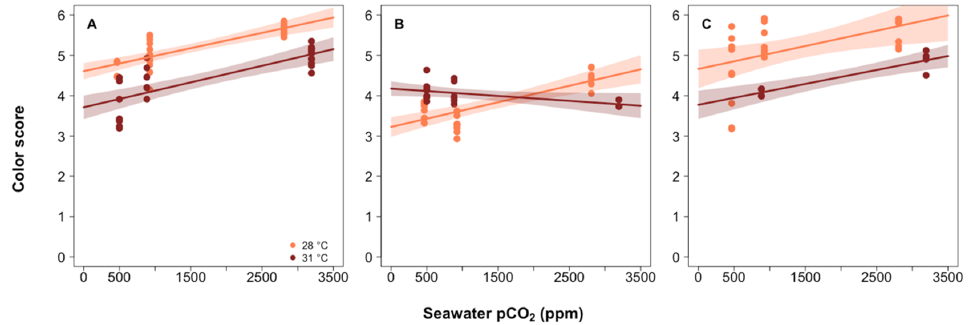
Figure 6. The effect of seawater pCO 2 and warming on the color score of the three species of tropical corals (( A ): S. pistillata ; ( B ): S. hystrix ; ( C ): P. damicornis )). Color score is a proxy for photosymbiont abundance (‘bleaching’), where 0 = bleached and 6 = healthy. Trendlines indicate significant corre- lations between seawater pCO 2 and color score at 28 (orange) and 31 (red) °C. The color score of both S. pistillata and P. damicornis increased in response to increasing pCO 2 (lmers, S. pistillata , p < 0.001; P. damicornis , p = 0.001) and decreased in response to a 3 °C temperature increase (lmers, S. pistillata , p < 0.001, P. damicornis , p = 0.001). Color score of S. hystrix was significantly impacted (indicating bleaching) by an interaction between pCO 2 and temperature (lmer, p < 0.001), whereby color score increased significantly with increasing pCO 2 at 28 °C (lmer, p < 0.001) but showed no significant change with increasing pCO 2 at 31 °C (lmer, p = 0.056). Shaded boundaries represent 95%